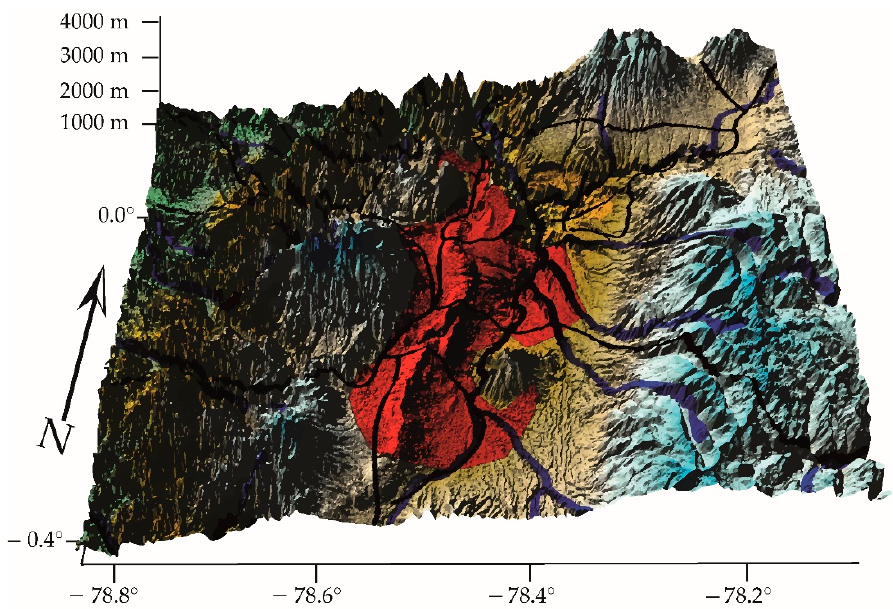
Figure 16. Geomorphology of Quito, Ecuador, C K, Tumbaco = 1.17, C K, Carapungo = 1.40, local micromete- orology is superimposed on the effect of pollutants (GCS, WGS84). (j) The Andacollo station is located within the commune of the same name, Cordilleran city of Coquimbo (Figure 17):